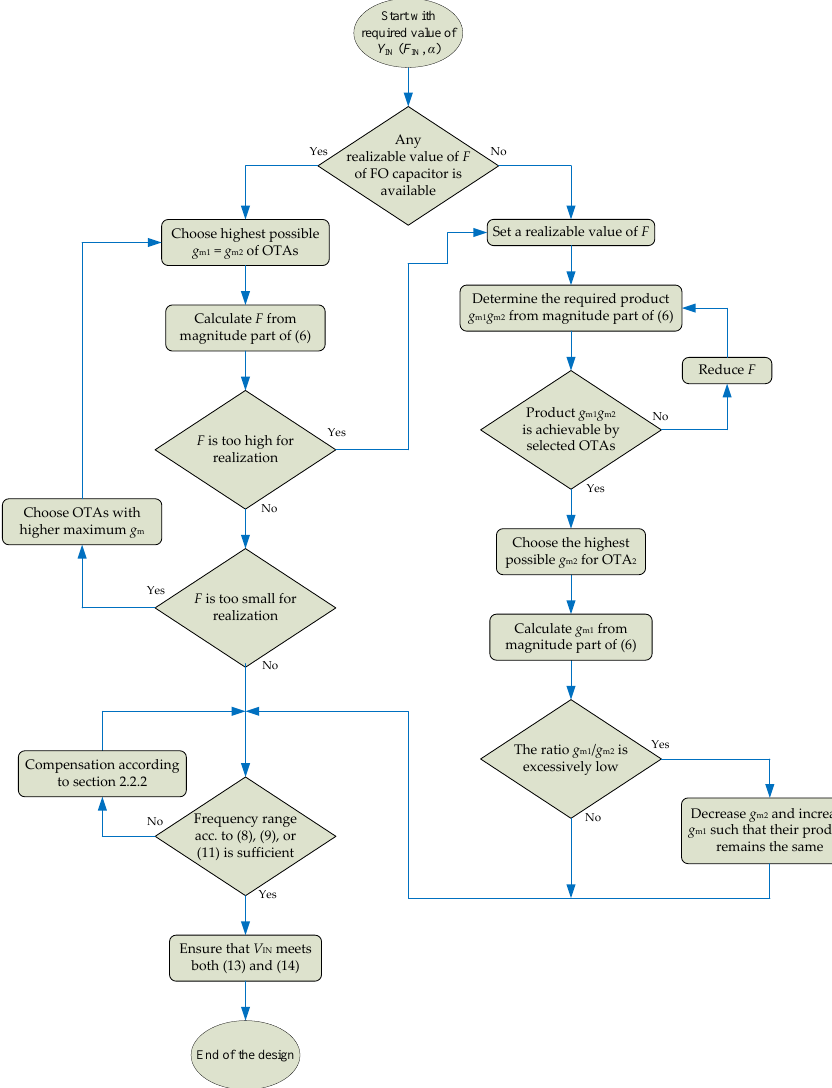
Figure 7. Flowchart of the setting of gyrator parameters.